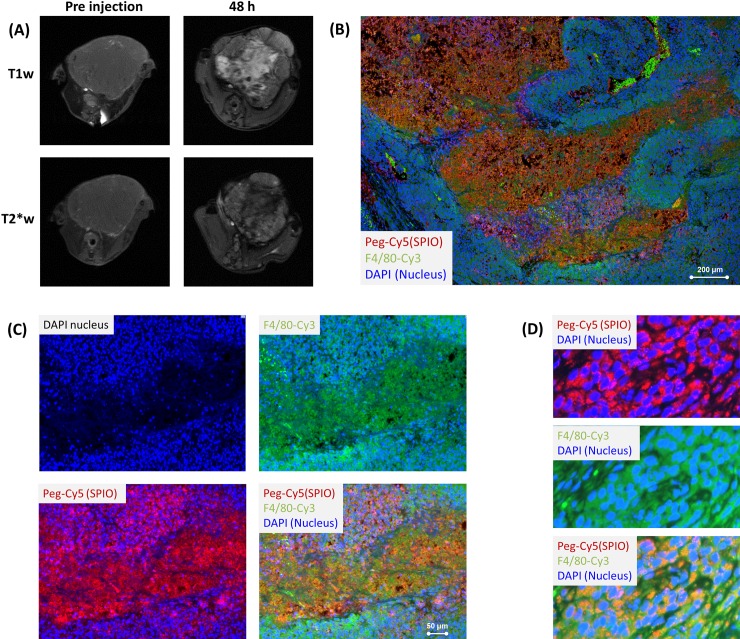
GEH121333 Tumor T1-enhancement corresponds to free iron oxides in central necrosis.(A) Axial T1- and T2*-weighted MR images of a representative PymT tumor before and 48 hours post injection (p.i.) of ferumoxytol at a dose of 0.5 mmol Fe/kg. Note homogenous tumors on pre-contrast images. The tumor center demonstrates hyperintense (bright) T1-enhancement and hypointense (dark) T2*-enhancement while the tumor periphery demonstrates hypointense enhancement on both sequences. (B) Corresponding histopathology (20x magnification) demonstrates areas of apparently free PEG-Cy5 (red) positive iron oxides in central tumor areas. F4/80 positive (green) macrophages outline these central areas. (C) Higher magnification (40x magnification) of the central tumor area confirms free PEG-Cy5 positive iron oxides (red) in central, necrotic tumor areas with low cell quantity (DAPI, blue). (D) Closer evaluation of peripheral tumor areas with high cell content demonstrate PEG-Cy5 (red) positive iron oxides co-localized to abundant F4/80 positive (green) macrophages.